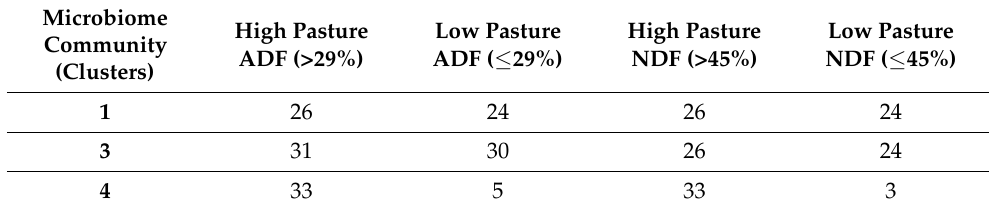
Table 6. Frequency table of pasture ADF and NDF conditional on microbiome community clusters. ADF and NDF were categorized as high or low based on median values.